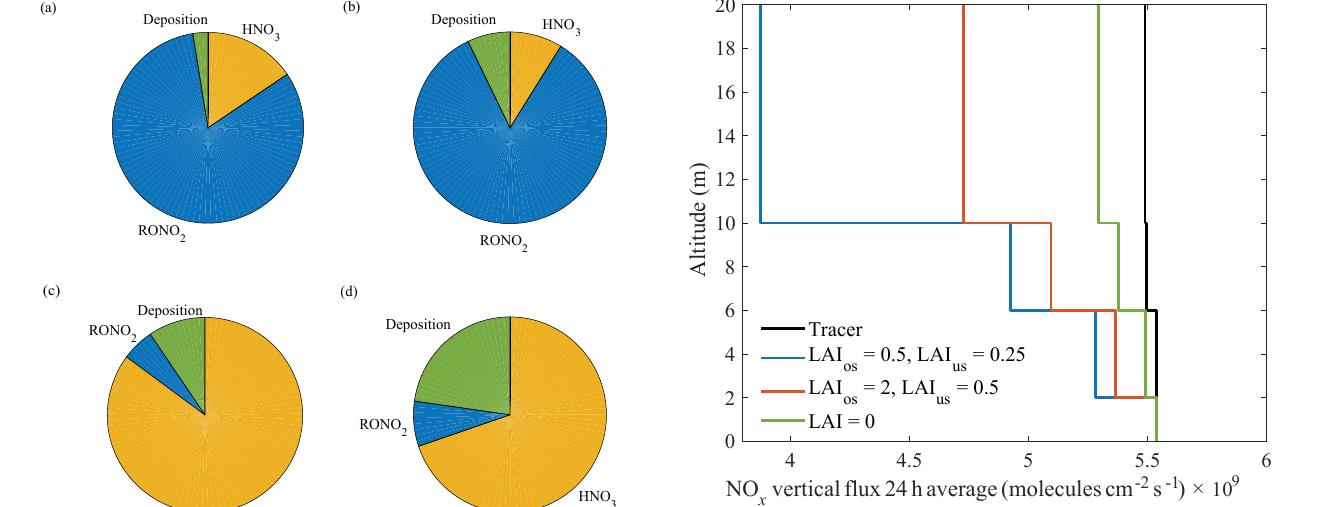
Figure 6. 24h average vertical fluxes of NO x predicted by the 1-D multibox model for a California oak woodland using the leaf resis- tances measured in this study. Model runs were conducted for low (red) and high (blue) LAI cases and for a no-deposition scenario